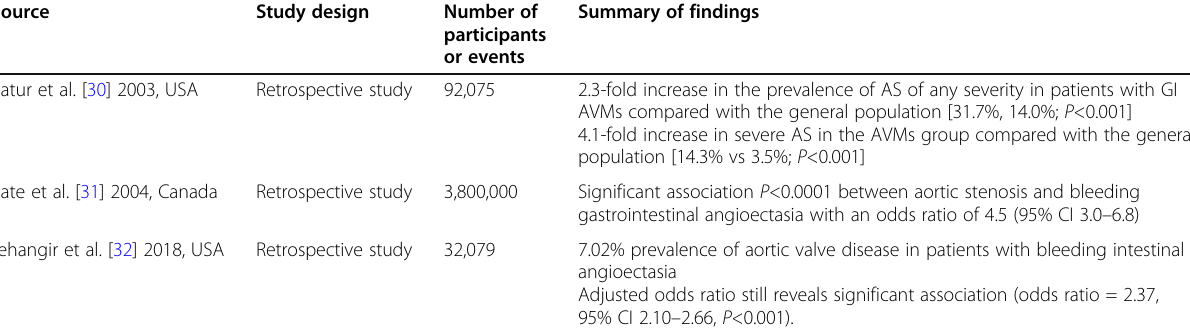
Table 1 Studies evaluating the association between angioectasia and aortic stenosis Source Study